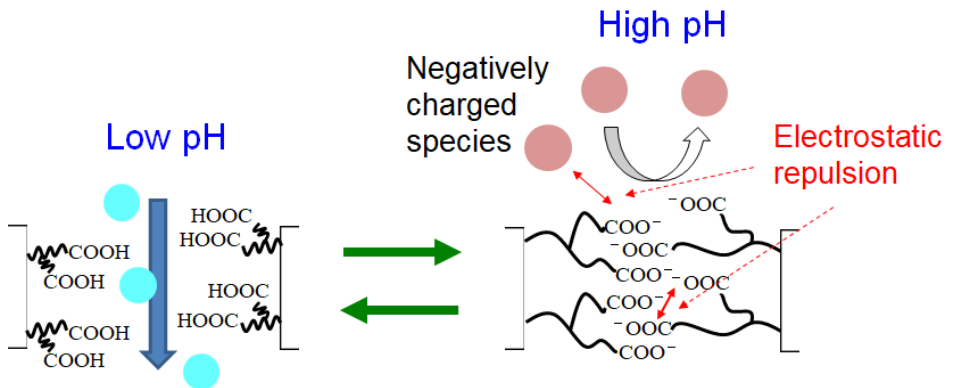
Figure 10. Proposed mechanism of pH dependence on permeation for the PAA-coated alumina Figure 10. membrane.